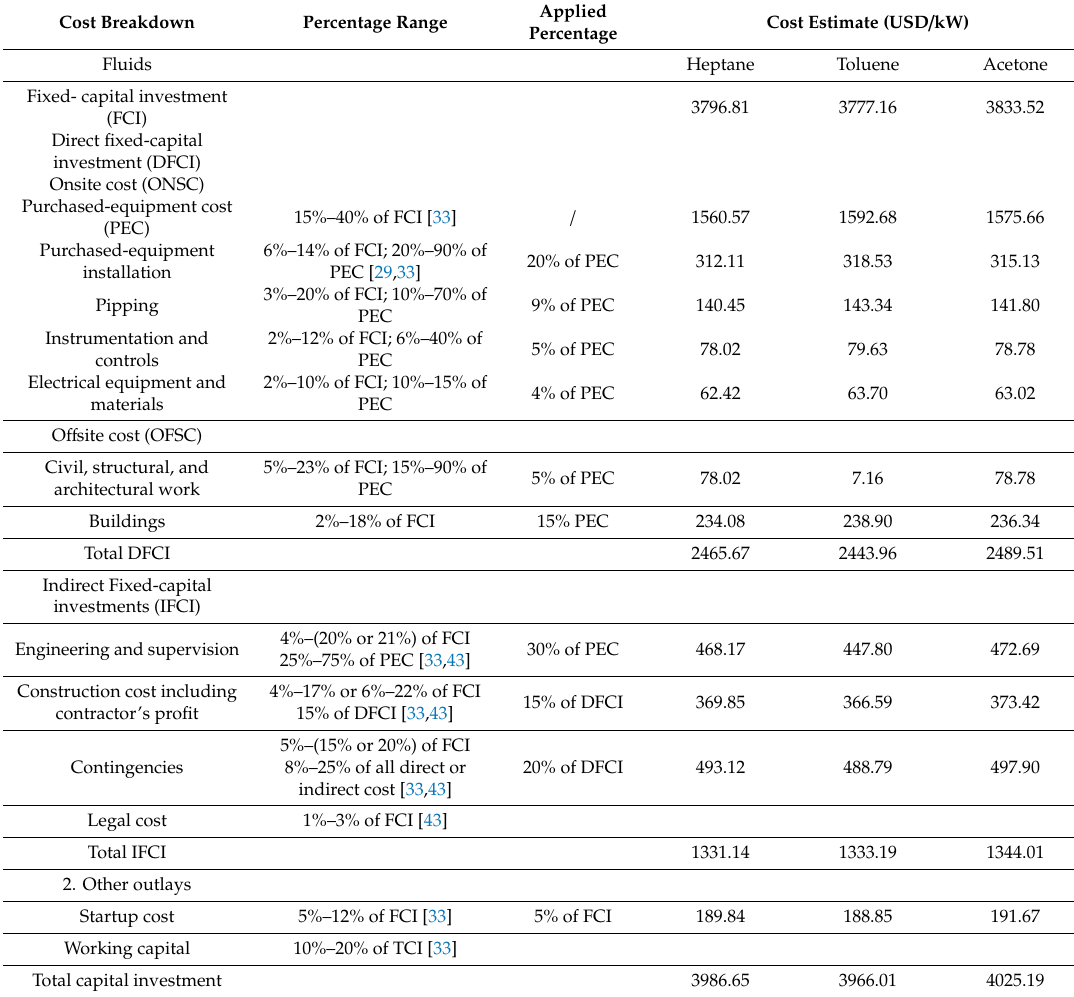
Table 9. Total investment costs estimation for the di ff erent working